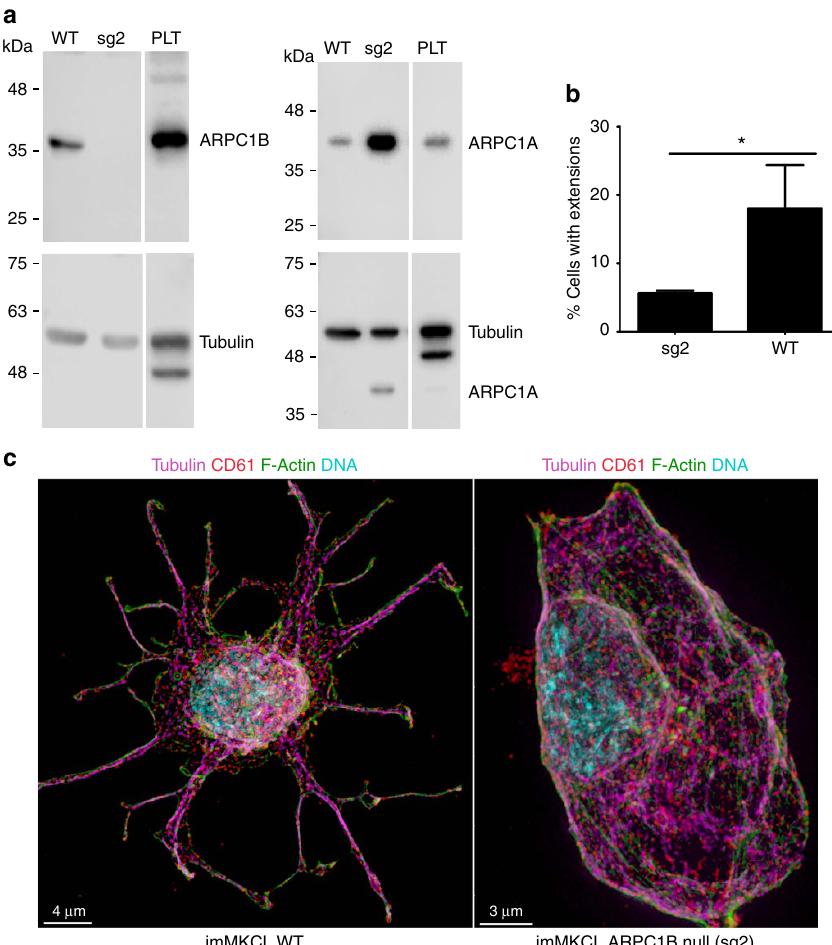
Figure 9 | Decreased proplatelet formation in ARPC1B-null megakaryocytic cells. ( a ) Cell lysate immunoblot analysis showing absent ARPC1B and increased ARPC1A expression in the ARPC1B-null imMKCL megakaryocytic cell line (sg2) relative to wild-type (WT) imMKCL cells and normal platelets (PLT; tubulin loading control for ARPC1B and ARPC1A indicated). ( b ) Wild-type and ARPC1B-null imMKCL cells were stimulated to differentiate in culture, and CD61-positive cells were scored for the presence of proplatelet-like extensions after 5 days; ARPC1B-null (sg2) cells showed a significantly decreased frequency of proplatelet formation compared to WT (* P o 0.05, two-tailed t -test; three experiments with 100 cells per group scored; bars show s.d.). ( c ) Comparisons of mature cultured representative wild-type imMKCL (left) and ARPC1B-null (right) cells; cells were stained and imaged by laser fluorescence structured illumination microscopy. Only cells expressing ARPC1B were observed to develop multiple structures resembling megakaryocyte proplatelets, containing tubulin and long, thin branched actin fibres (3D renders of images; bars ¼ 4 m m left, 3 m m 30–90min. Adhered cells were then fixed with either 4% PFA (for IF) or with Gel (NativePAGE, Novex, Invitrogen), electrophoresed and transferred on to 2% glutaraldehyde (for electron microscopy), rinsed in appropriate buffers and PVDF membrane according to the manufacturer’s recommendations. For stored at 4 (cid:2) C with high humidity before preparation for imaging. two-dimensional gels (2D gels), individual gel lanes were cut, incubated in SDS–PAGE sample buffer containing b -mercaptoethanol for 30min, and run in a 10% SDS-PAGE gel along with a MW marker and lysate sample. The gel was then blotted on to nitrocellulose membrane. For analysis of individual proteins lysates were diluted in reducing sample buffer and separated on 4–20% SDS–PAGE gels before blotting on nitrocellulose. Both PVDF and nitrocellulose membranes were probed with antibodies to Arp2/3 complex components (dilutions specified under Antibodies) and imaged via chemiluminescence in a Li-Cor Odyssey FC system; images were exported to Adobe Photoshop using Image Studio Lite software. Preparation of resting and fibrinogen spread platelets . For resting platelets, PRP (above) was mixed with an equal volume of PBS plus 8% paraformaldehyde (PFA) and incubated for 10min at room temperature. Fixed platelets were recovered via centrifugation, washed in PBS and resuspended at approximately 200 cells per nl in PBS plus 1% bovine serum albumin fraction V (BSA, MP Biomedicals), and 50 m l aliquots were spotted onto glass coverslips, incubated for 90min at 37 (cid:2) C with 100% humidity and rinsed with PBS. For platelet spreading, glass coverslips were treated with human fibrinogen (Sigma-Aldrich) for 30min at 37 (cid:2) C, then rinsed with PBS and allowed to dry. Aliquots of PRP or washed platelets (above) resuspended in Tyrode’s solution (pH 7.2) were gently layered upgrade, 4 diode-pumped solid state laser lines (Spectral Applied Research, 405, onto fibrinogen-treated surfaces and platelets were allowed to spread for